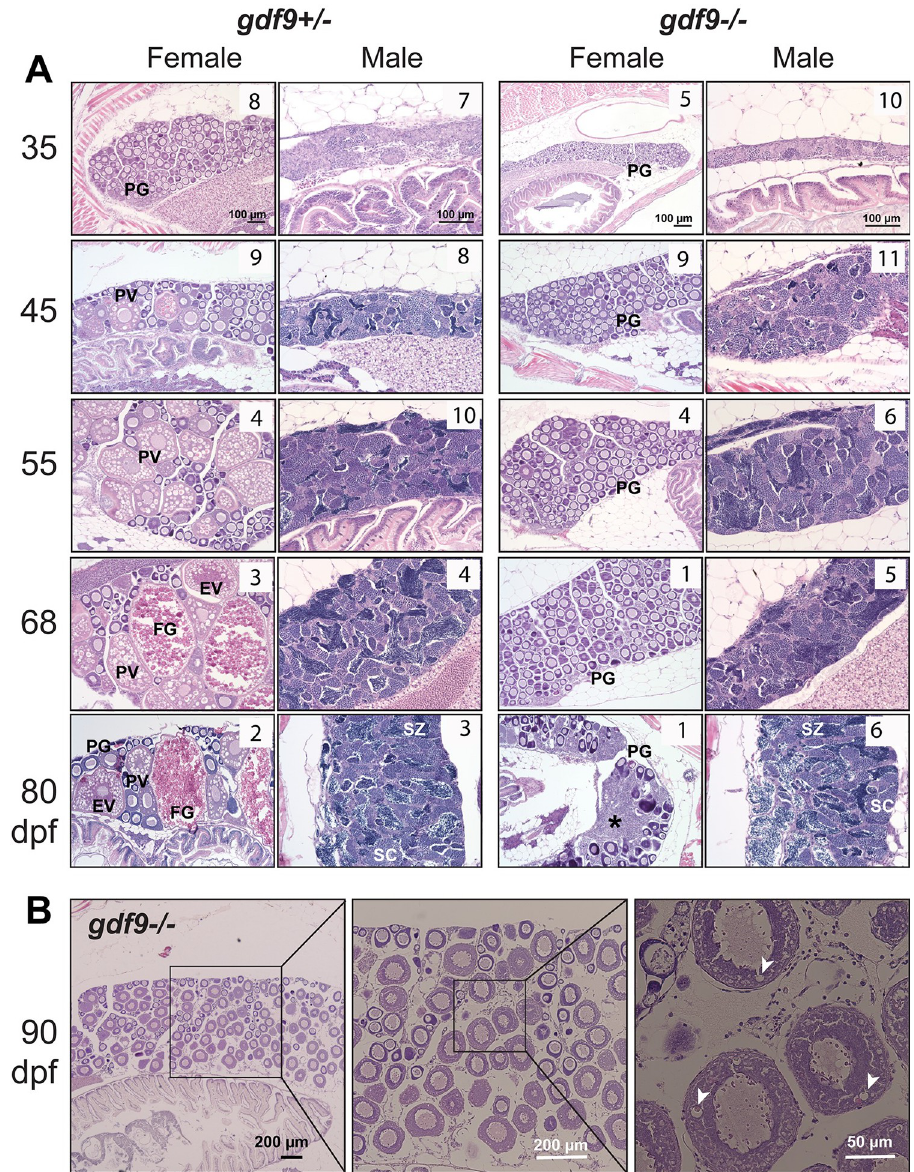
Fig 2. Gonadal development from sex differentiation to maturity in gdf9 mutant. (A) Temporal development of the ovary and testis in the control ( gdf9+/- ) and mutant ( gdf9-/- ) from gonadal differentiation (35 dpf) to puberty onset (45 dpf) and sex maturity (80 dpf). The mutant females started to differ from the control at 45 dpf when the first cohort of PV follicles with cortical alveoli emerged in the control ovary, marking the onset of puberty. No PV follicles were observed in the mutant ovary, and the follicles remained arrested at PG stage during the entire examination period. At 80 dpf, the mutant females were undergoing sex reversal to males with remnant follicles and infiltrating stromal and testicular tissues (asterisk). The testis and spermatogenesis were normal in the mutant males compared to the control. The number in each photo indicates the number of fish examined with the same phenotype. (B) Very few gdf9 mutant females could cross the PG-PV transition and their follicles showed rudiment cortical alveoli (arrowhead). PG, primary growth; PV, pre-vitellogenic; EV, early vitellogenic; FG, full-grown; SC, spermatocytes; SZ,